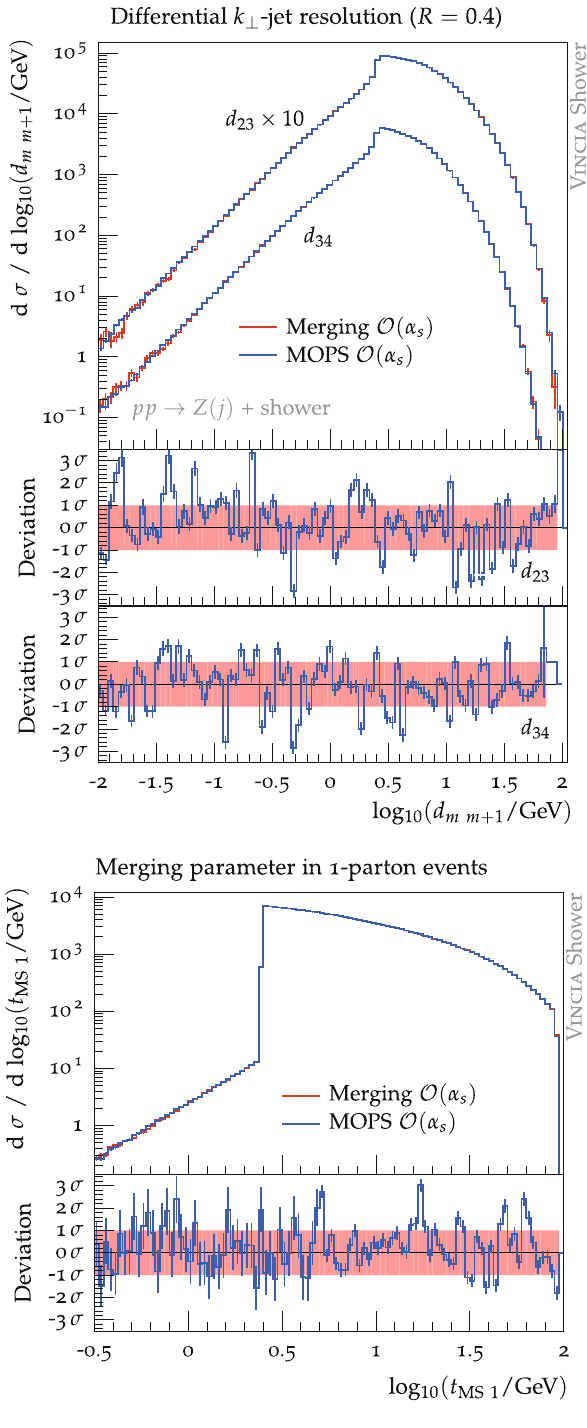
Fig. 7 Parton-level results for pp → Z + jets: the distribution of the merging scale in exclusive 1-parton events ( bottom ) and the logarithmic distributions of differential jet resolutions ( top ). Merged predictions with a merging-scale value of 5 GeV are compared to predictions with the MOPS method find possible clusterings. For the validation we use parton- level results with a fixed α s for both methods and do not include events that cannot be reproduced by Vincia with an